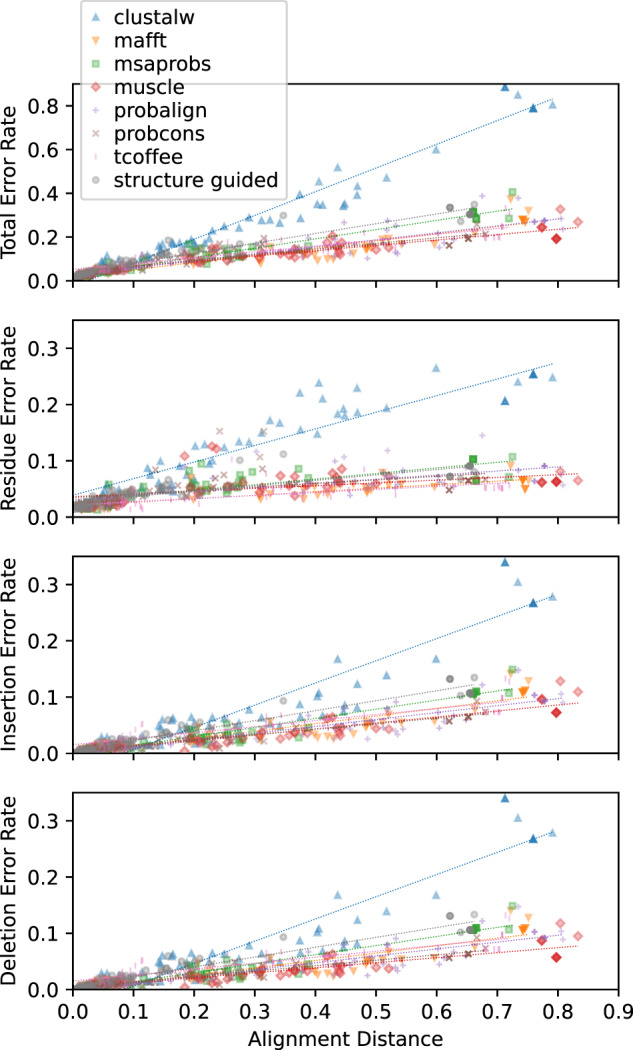
Errors in ASR correlate with alignment errors. We simulated protein evolution using empirically derived conditions from five protein domain families and aligned the resulting sequences using structure-guided and seven different sequence-alignment methods. We measured the position-wise distance of each alignment from the correct simulated alignment (x axis), which estimates the probability of selecting two incorrectly aligned residues at random. We used each alignment to infer the most likely ancestral sequence at each node on the phylogeny and compared the inferred ancestral sequence to the correct simulated sequence to estimate ASR error rates. ASR errors were divided into four categories: 1) residue errors, in which both correct and inferred ancestral sequences have a residue at a given position in the alignment, but the residues differ; 2) insertion errors, in which the inferred sequence has a residue at a given alignment position, but the correct sequence has a gap; 3) deletion errors, in which the inferred sequence has a gap, but the correct sequence has a residue, and 4) total errors. Sequence-wide error rates (errors/site; y axis) were computed by dividing the number of errors by the length of the pairwise alignment of the inferred and correct ancestral sequences. Dotted lines indicate least-squares linear regressions.